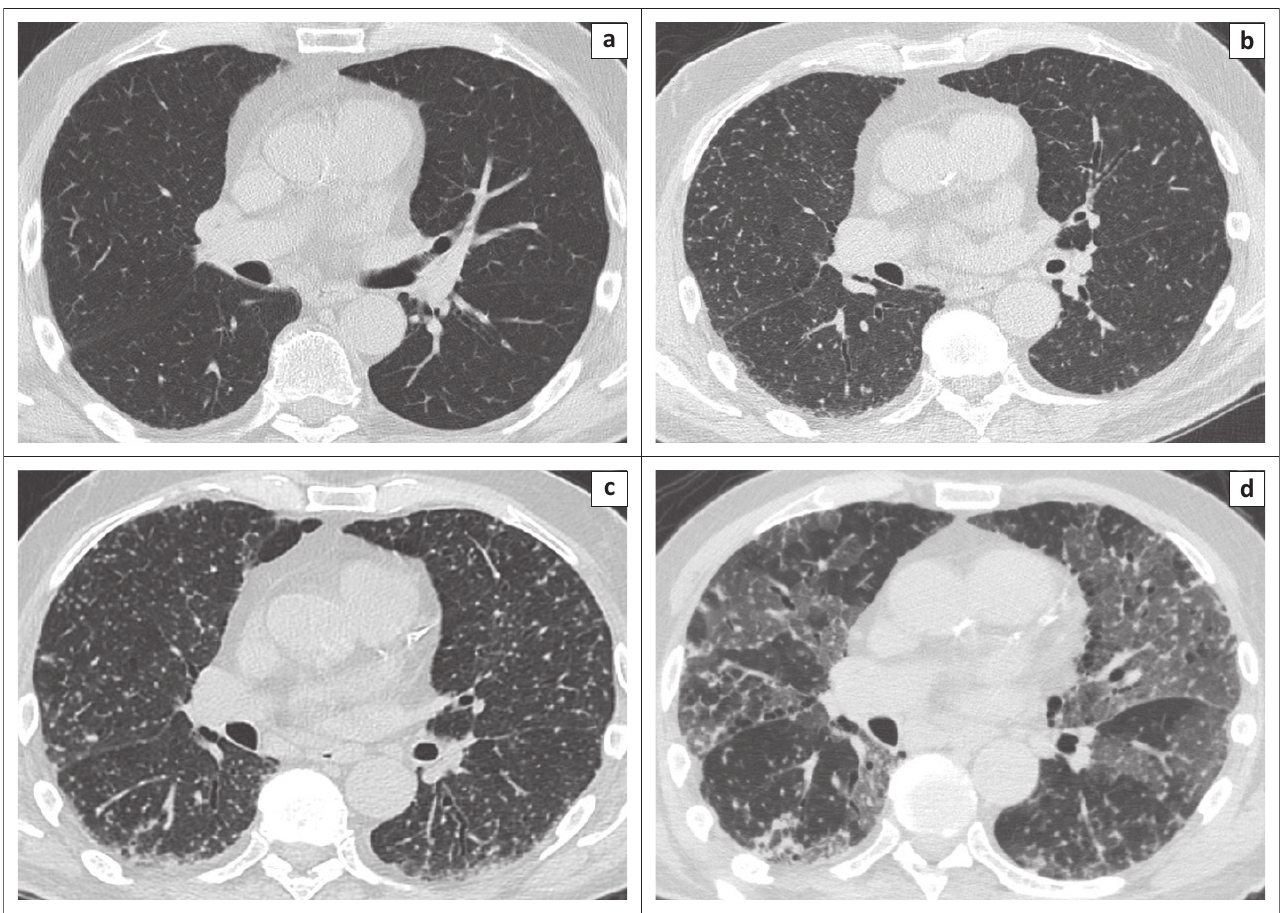
FIGURE 1: A normal CT of the chest performed before the patient’s access to the Emergency Department (a). A CT scan of the same patient performed 10 days after the last Bacillus Calmette-Guérin instillation, showing 1 mm – 2 mm diameter nodules disseminated throughout the lung and distributed randomly with respect to the lobular structures in a miliary pattern (b). After two weeks of antibiotic therapy, CT imaging revealed a numerical and dimensional increase in the multiple micronodules (c). Despite the administration of anti-tubercular therapy, the patient’s clinical condition deteriorated again, requiring a new CT scan that revealed the presence of bilateral ground-glass opacities localised mainly in the middle and lower parts of the lungs, partially superimposed on the previously seen multiple lung micronodules, compatible with coronavirus disease 2019 superinfection